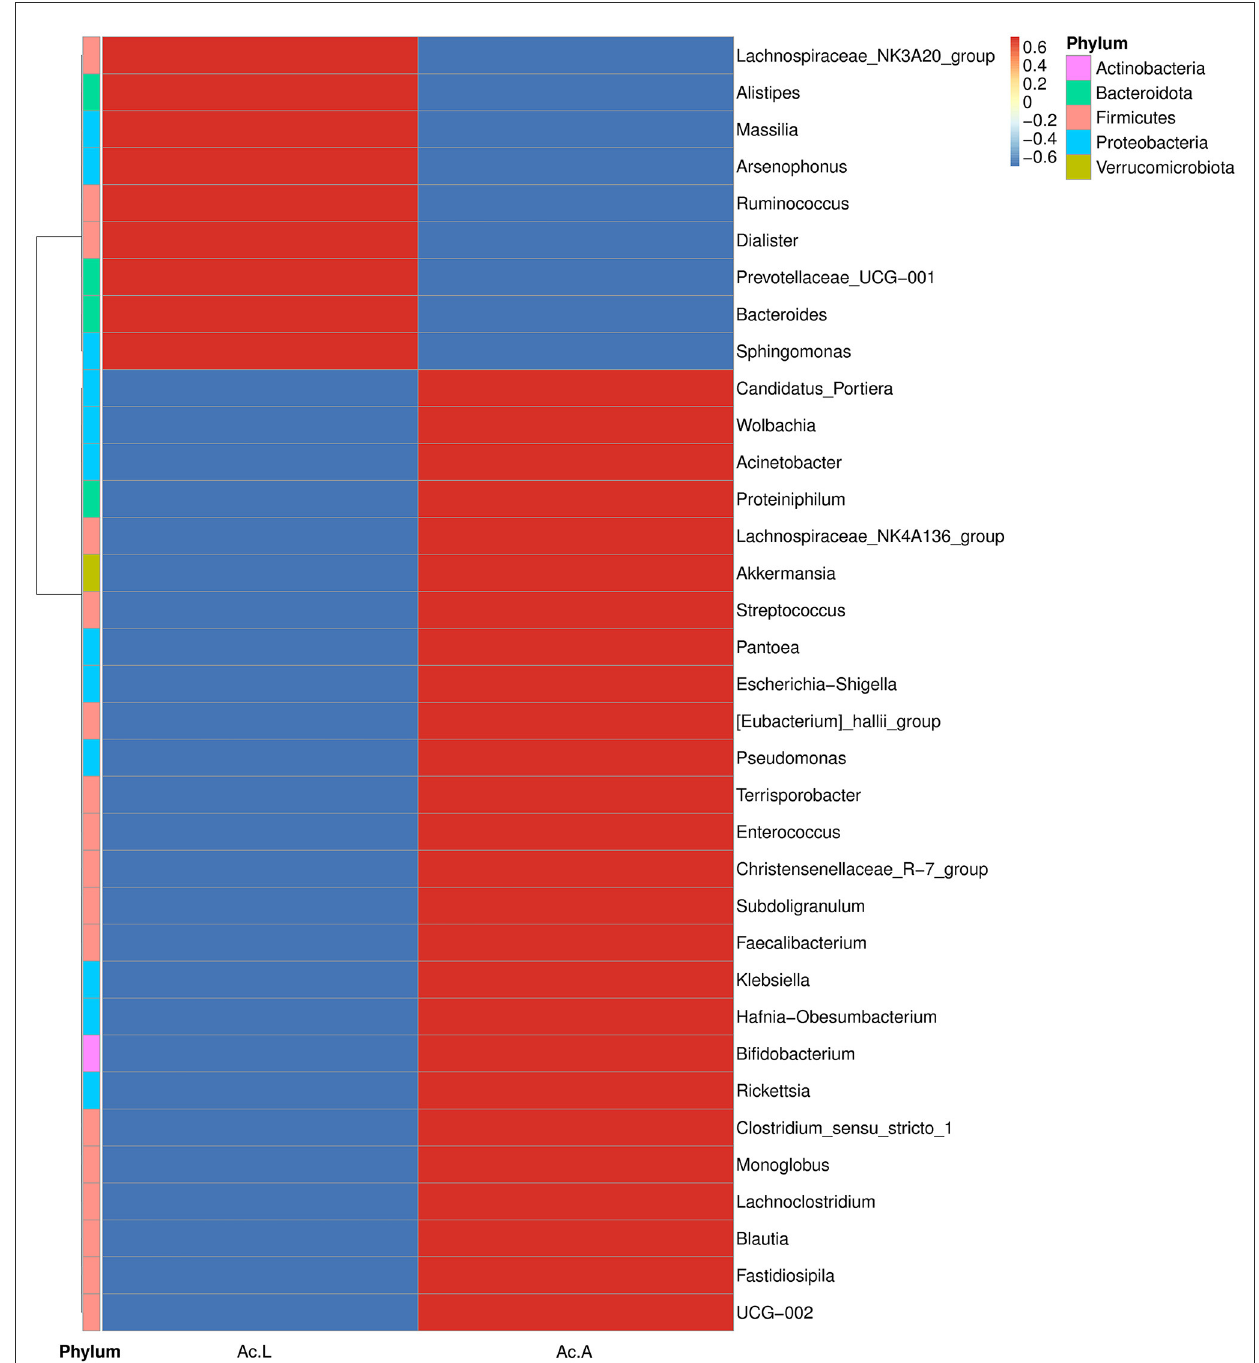
FIGURE3 Heat map analysis of the top 35 microbial populations with relative abundance at A. camelliae. Ac. L and Ac. A refers to larvae and adults of A. camelliae, respectively.